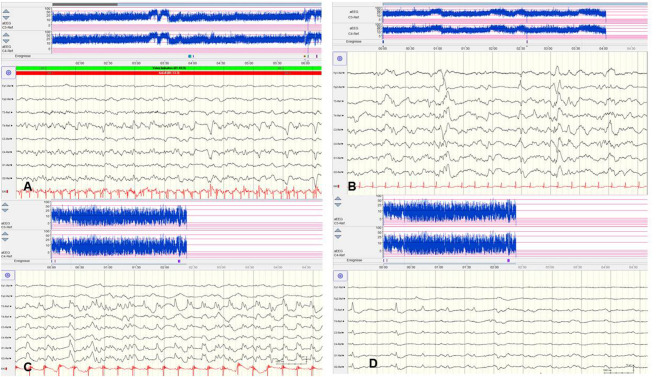
Focal epileptic discharges with a normal (A,B) and suppressed background (C,D). (A,B) EEG in a 2-day-old term newborn presenting tonic seizures with opisthotonos and apnoea. Ictal EEG (A) showed focal epileptic discharges that were also present during interictal periods (B). A saw-tooth pattern of the aEEG (C3, C4) indicates repetitive subclinical electrographic seizure activity. BFNC caused by a heterozygous KCNQ2 mutation was diagnosed. Neurodevelopmental outcome was normal. (C,D) EEG in a 10-h-old term newborn with moderate perinatal HIE (Sarnat stage II) and therapeutic hypothermia. Multichannel EEG (C,D) shows prolonged focal epileptic discharges and severely suppressed background activity. Suppressed lower amplitudes (<5 μV) and saw-tooth pattern of the aEEG (C3, C4) are shown. (Calibration is given in the figure, low-pass 30 Hz, high-pass 0.5 Hz).